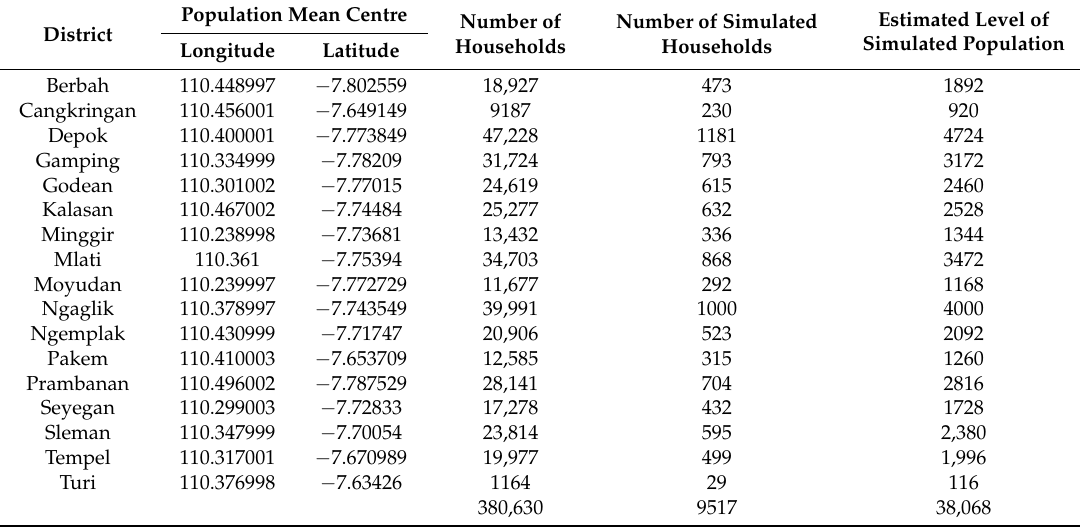
Source: BPS [125] and spatial analysis of land use data.